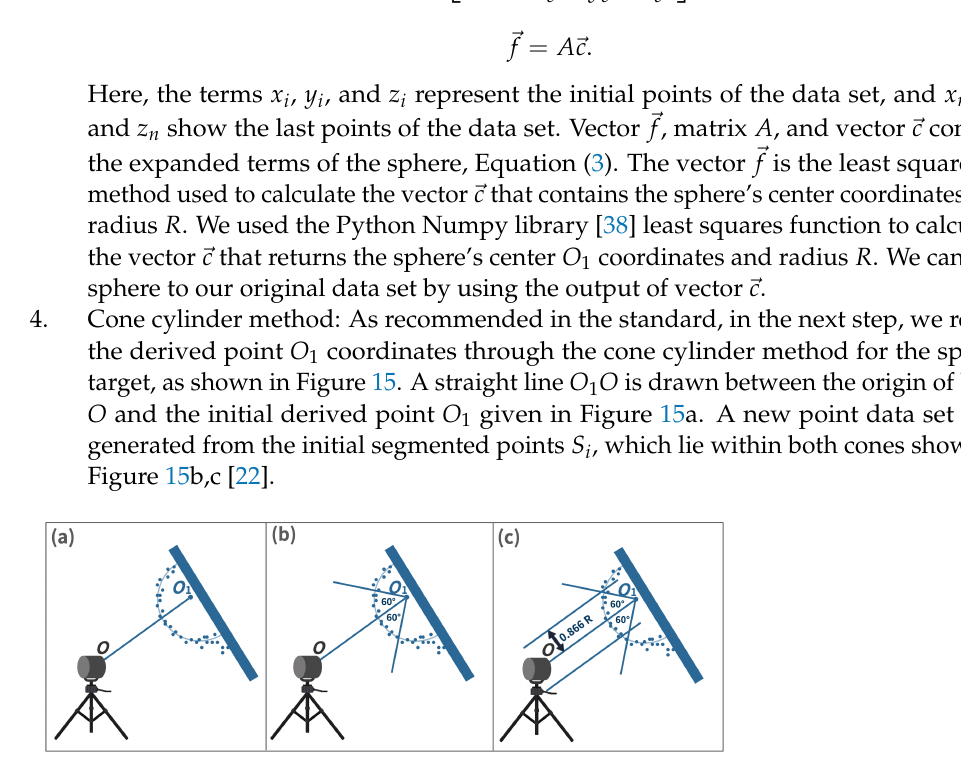
Figure 15. Cone cylinder method. ( a ) A straight line O 1 O is drawn between the origin of the DUT and the initial derived point. ( b ) A cone with an apex located at O 1 with an opening angle of 120 ◦ is constructed. ( c ) A cylinder collinear to O 1 O with 0.866 R is drawn, source: reproduced with permission from [22]